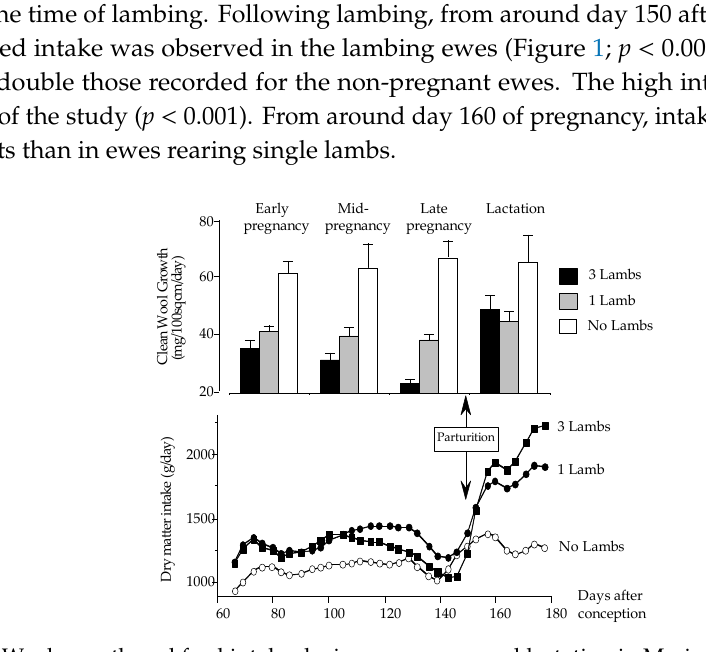
Figure 1. Wool growth and feed intake during pregnancy and lactation in Merino ewes bearing zero, one, or three fetuses, and then supporting zero, one, or three lambs.